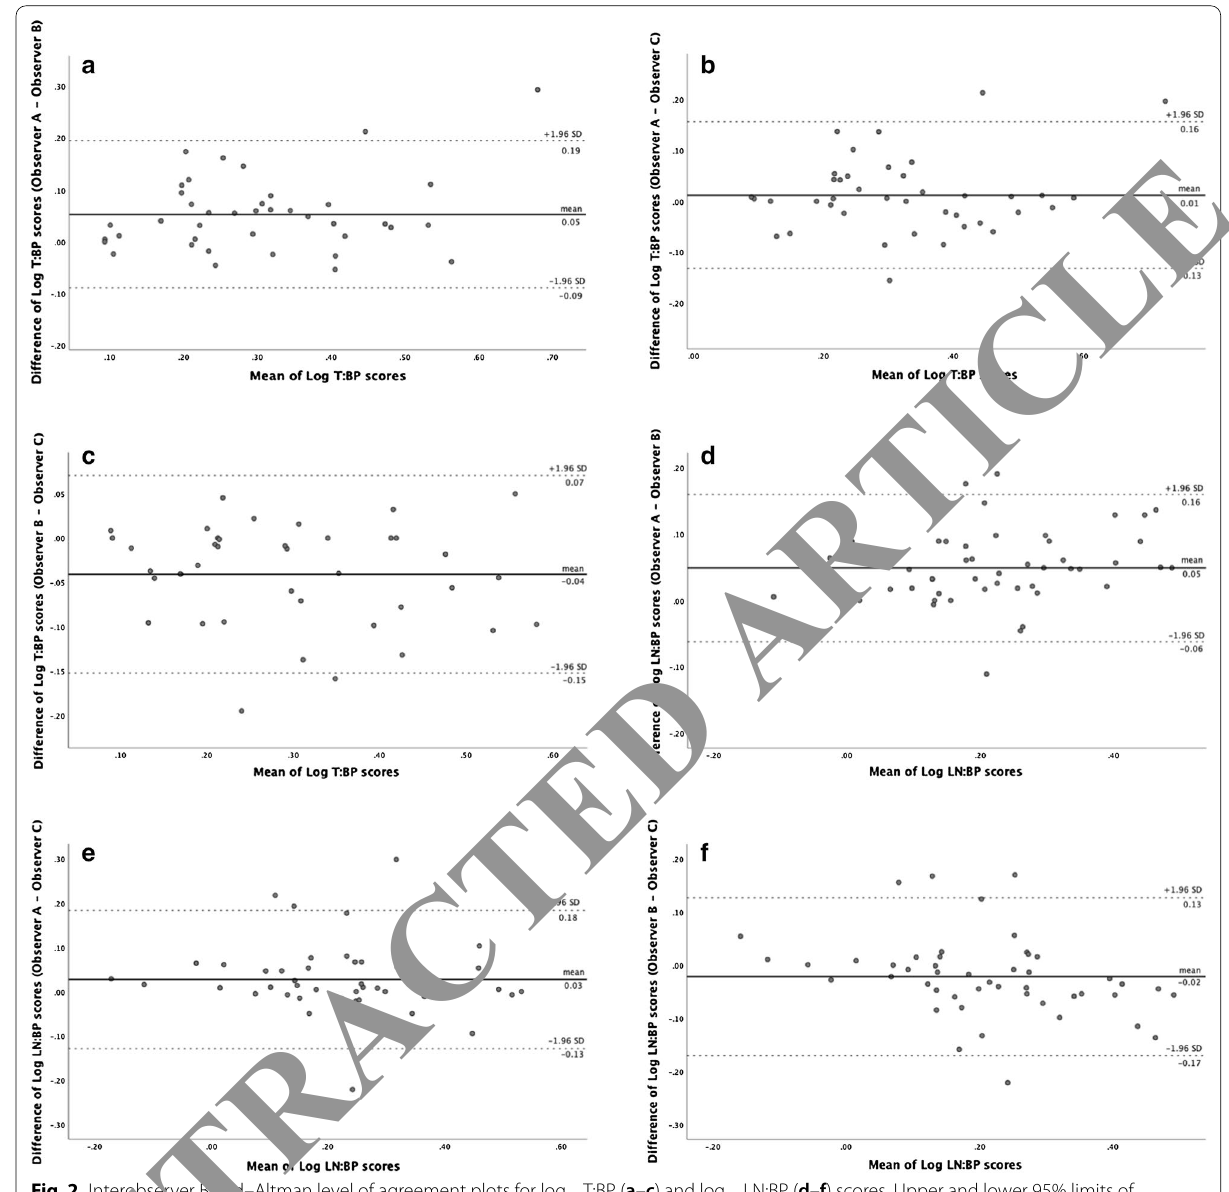
Fig. 2 Interobserver Bland–Altman level of agreement plots for log 10 T:BP ( a – c ) and log 10 LN:BP ( d – f ) scores. Upper and lower 95% limits of agreement represented by dashed lines. Solid horizontal lines represent between-observer mean difference. a T:BP scores observer A versus B ( β 0.13, p 0.117); b T:BP scores observer A versus C ( β = = observer A versus B ( β 0.11, p 0.047); e LN:BP scores observer A versus C ( β = = p =